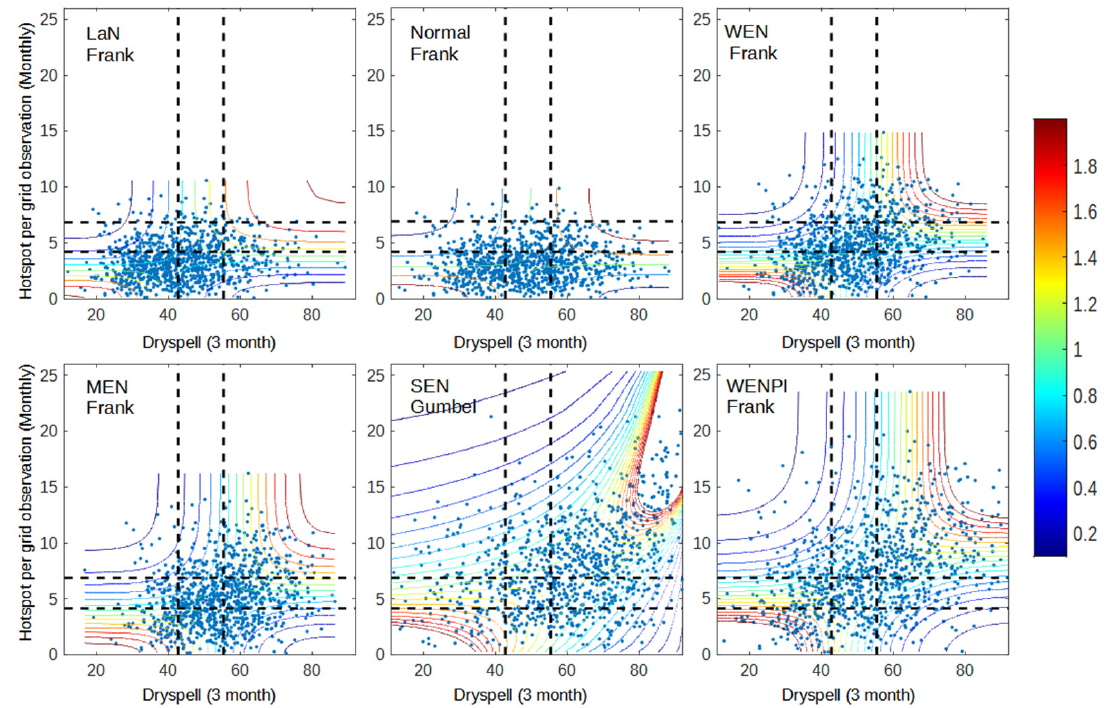
Figure 3. Dependency graph of dry spell and hotspot for 2001–2020 data. The dashed lines represent the separation of wet ( bottom / left ), normal ( middle ), and dry ( up / right ) conditions for dry spell (vertical line) and hotspot (horizontal line).